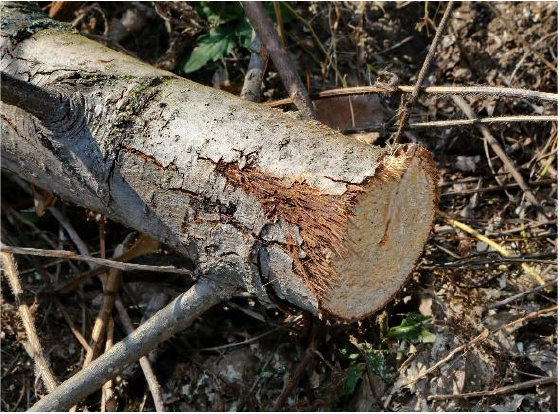
Figure 3. The root collar of a completely defoliated and dry poplar tree. Tree-level biomass loss was calculated as the differences between the average biomass accumulated from undefoliated trees and the average biomass accumulated from partially and completely defoliated trees, respectively. Next, the individual tree loss per defoliation class were multiplied by the number of trees that were assigned to a given defoliation class from an inventoried poplar row. Furthermore, defoliation class level data were added together to calculate the losses at row level, which were then extrapolated to